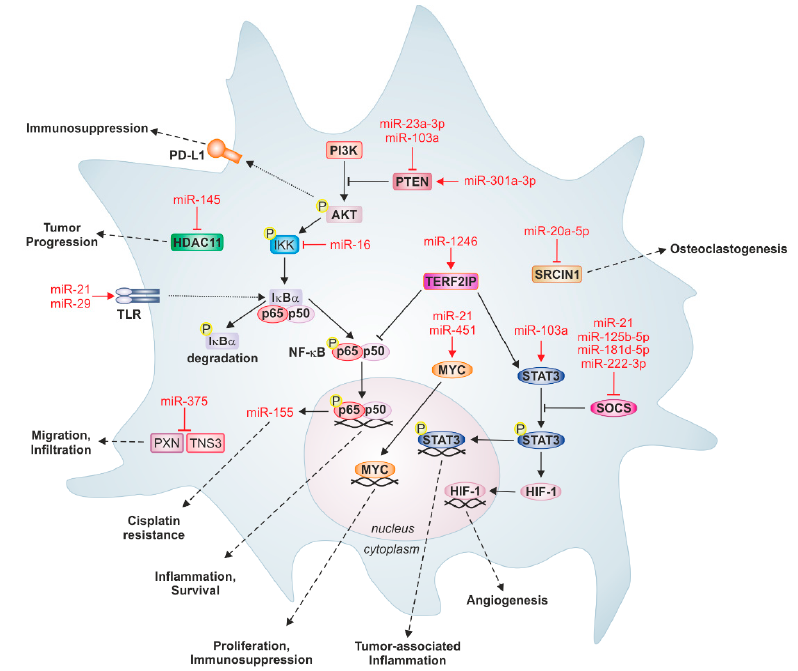
MiR-20a-5p from breast cancer cells targets SRC kinase-signaling inhibitor 1 (SRCIN1) in bone